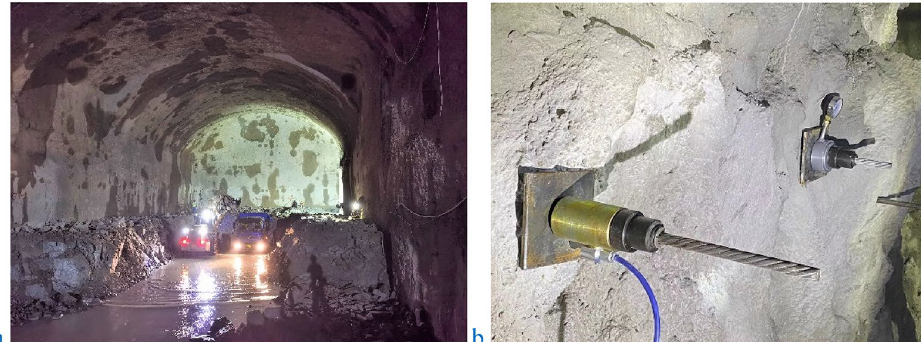
Figure 23. Real view of the tunnel.